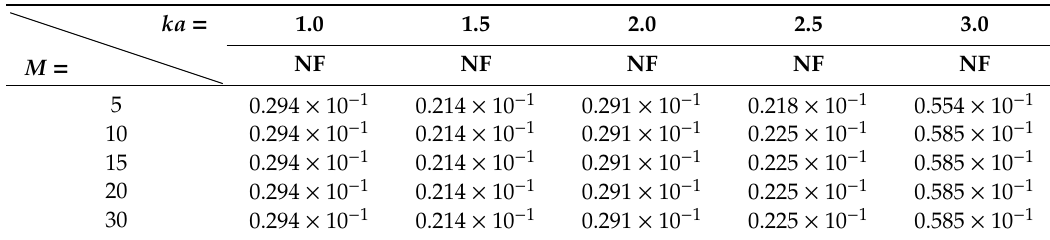
Table 1. Variation of the normalized mean drift wave force on the interior column, f − c , with respect to M ( d = 3 a , b = 2 a , and G 0 = 0.1).